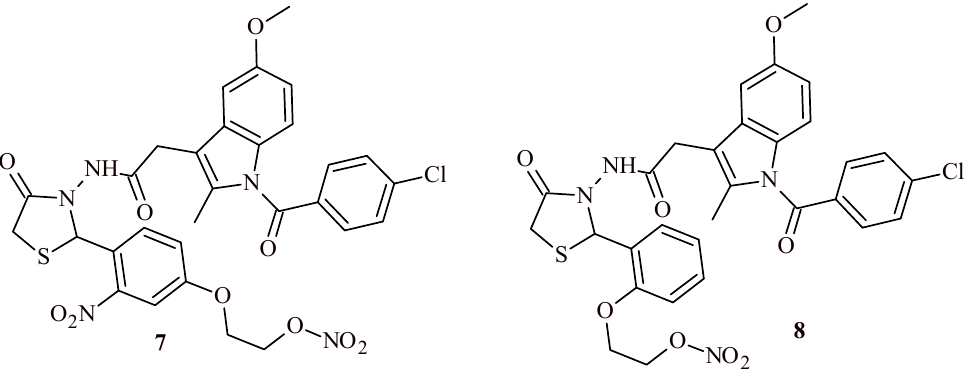
Figure 3. Thiazolidin-4-one-indometacin hybrids with antioxidant properties. The series of oxazinyl-thiazolidin-4-ones ( 9a – 9f ) were tested for their antioxidant ac- tivity in DPPH and nitric oxide (NO) radical scavenging activity assays (Figure 4) [22].